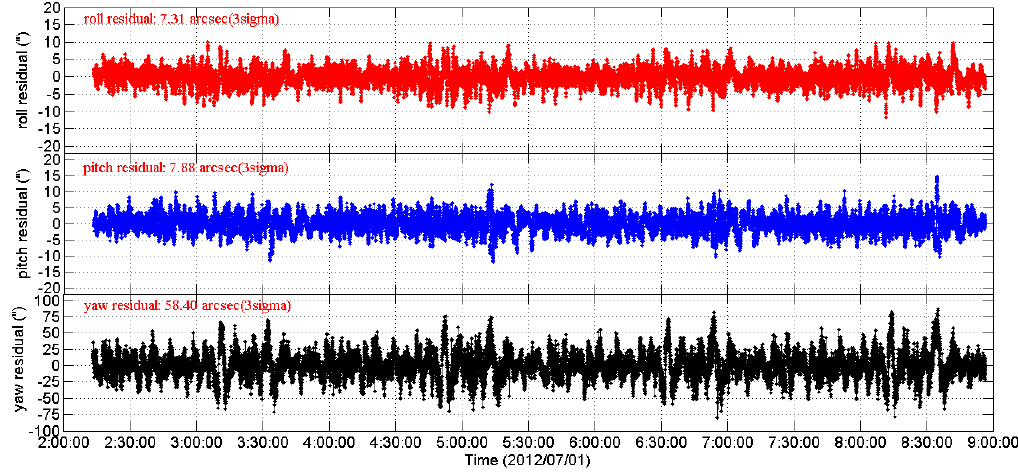
Figure 6. The 3-axes Euler angle residual streams of CCD01 vs. satellite mean anomaly.